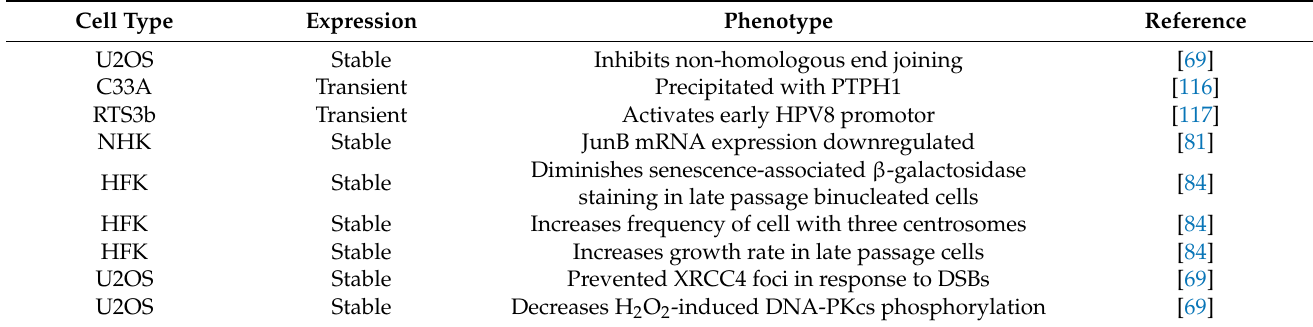
Table 2. Phenotypes of HPV8 E6 ∆ 132-136 analogous to wild type HPV8 E6. Cell lines abbreviations: human osteosarcoma cell line (U2OS), human foreskin keratinocytes (HFK), HPV-negative cervical carcinoma cell line (C33A), HPV-negative skin squamous cell carcinoma-derived cell line (RTS3b), primary human foreskin keratinocytes (NHK). “Stable” denotes stable expression achieved via lentiviral transduction. “Transient” denotes transient expression achieved via